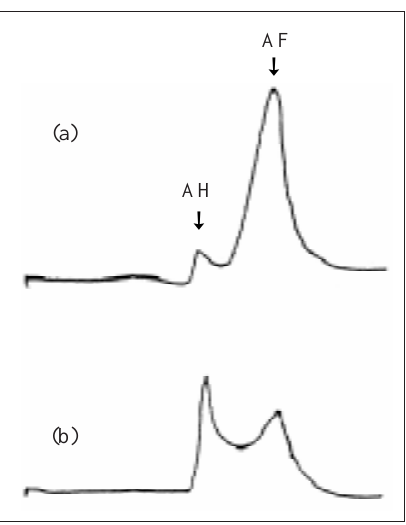
Figura 1. Cromatogramas de misturas de substâncias húmicas padrões, nas seguintes proporções: (a) 8%(AH ):92%(AF ) e (b) 57%(AH p p